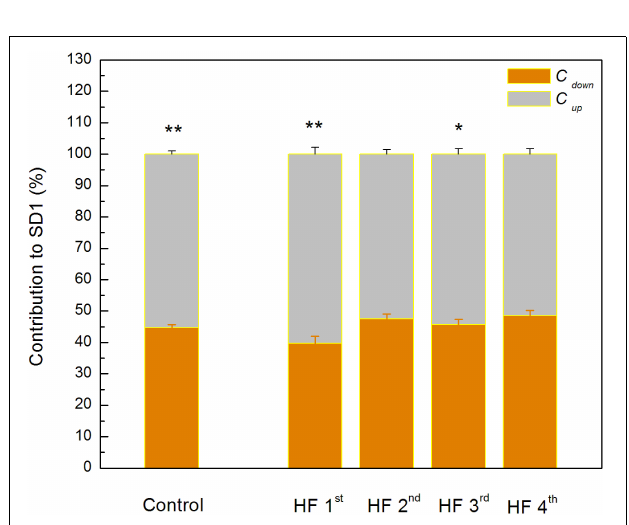
FIGURE 6 | Guzik’s variables of asymmetry in clusters of heart failure patients. Data are presented as mean values plus standard errors. ∗∗ p < 0.01, ∗ p < 0.05 ( C up vs. C down ). There is no significant difference between control group and each of clusters with heart failure